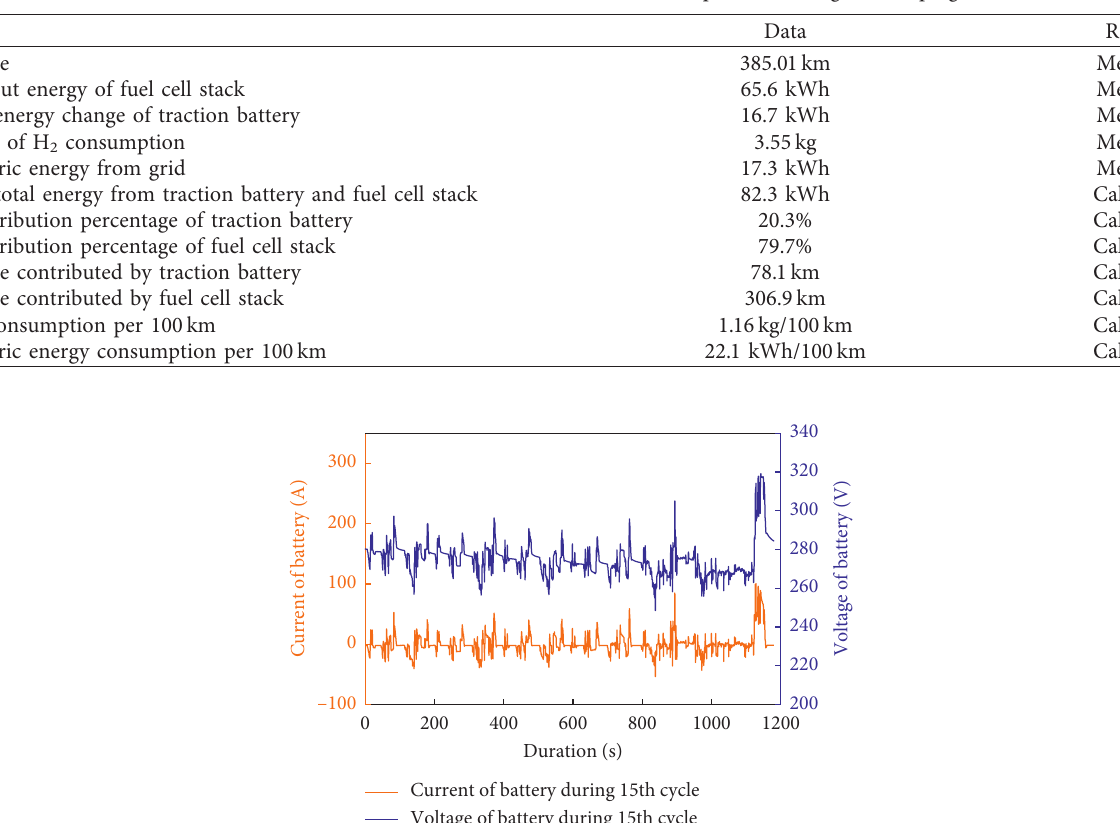
2 consumption and range of the plug-in FCV.